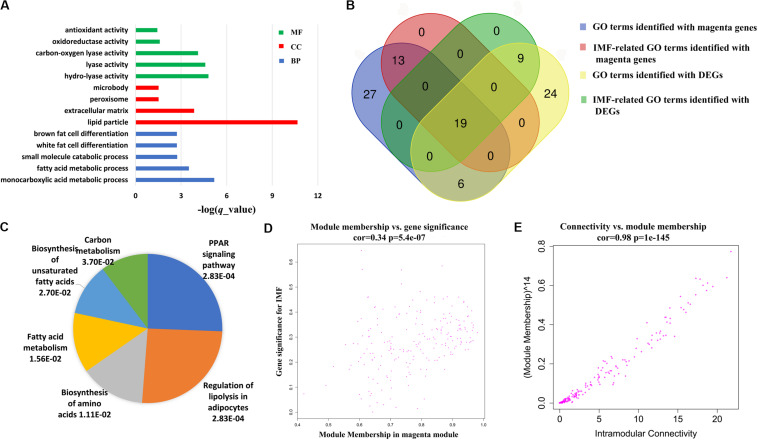
Coexpressed genes in magenta module. (A) The top 5 biological processes (BP) terms, all cellular components (CC), and molecular functions (MF) of Gene Ontology (GO) terms identified with magenta module genes. (B) Venn diagram of GO terms identified with magenta module genes and differentially expressed genes (DEGs). (C) Pie chart of all significant pathways (q < 0.05) in the magenta module. Each sector of the pie chart is proportional to the log10 (-q value) of each pathway it represents. (D) Association between the module membership (MM) and gene significance (GS) in the magenta module. (E) Association between the intramodular connectivity and module membership (MM) in the magenta module.